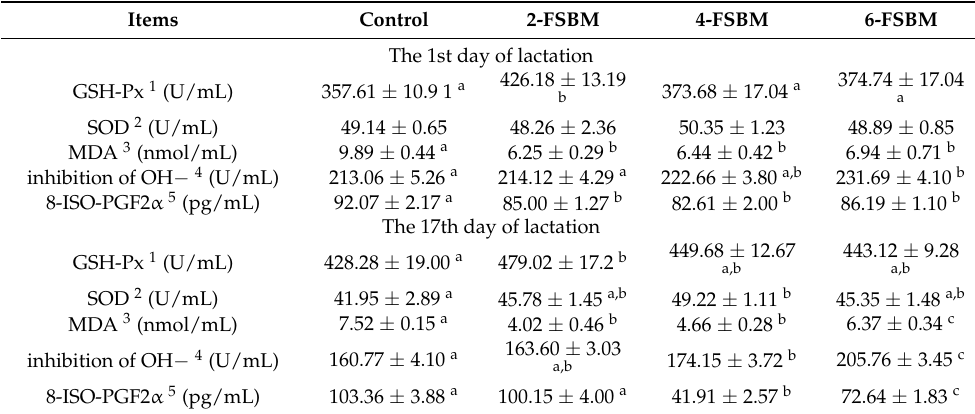
Table 4. The oxidative stress status in the serum of sows in different dietary groups.